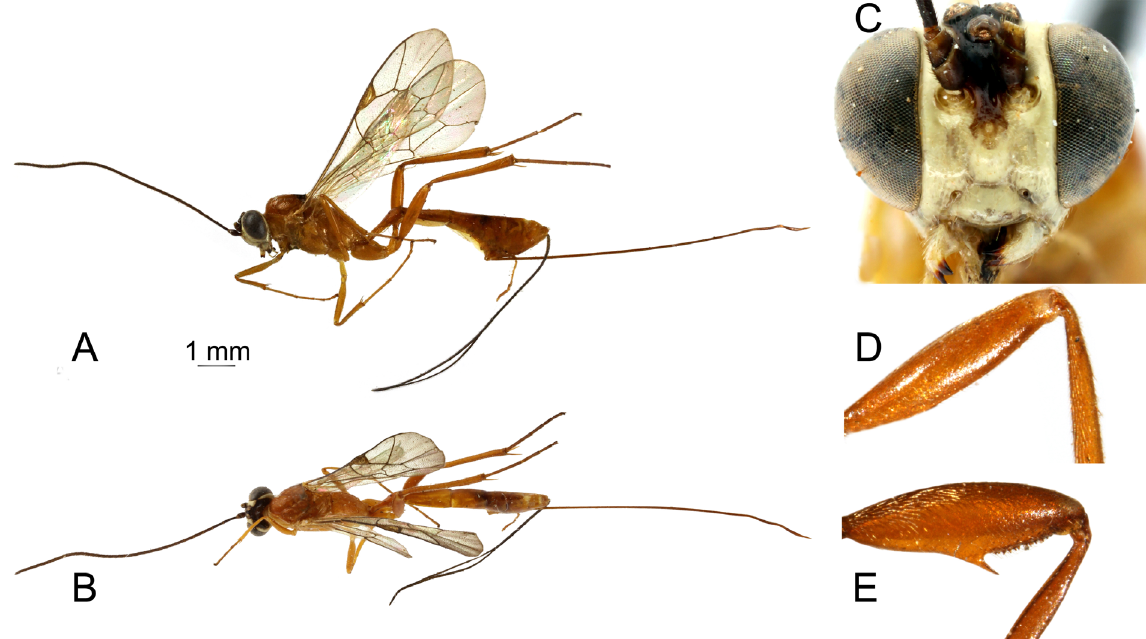
Fig. 7. Pristomerus hansoni sp. nov. A . ♀, habitus, profile. B . ♀, habitus, dorsal. C . ♀, head, facial. D . ♀, hind femur, profile. E . ♂, hind femur,